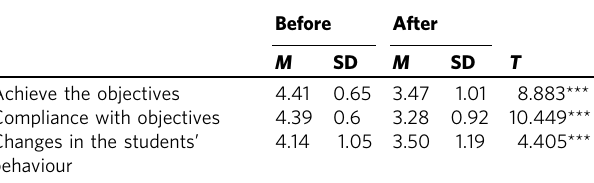
Table 3 Perceived effectiveness of the programme before and after con fi nement ( n =